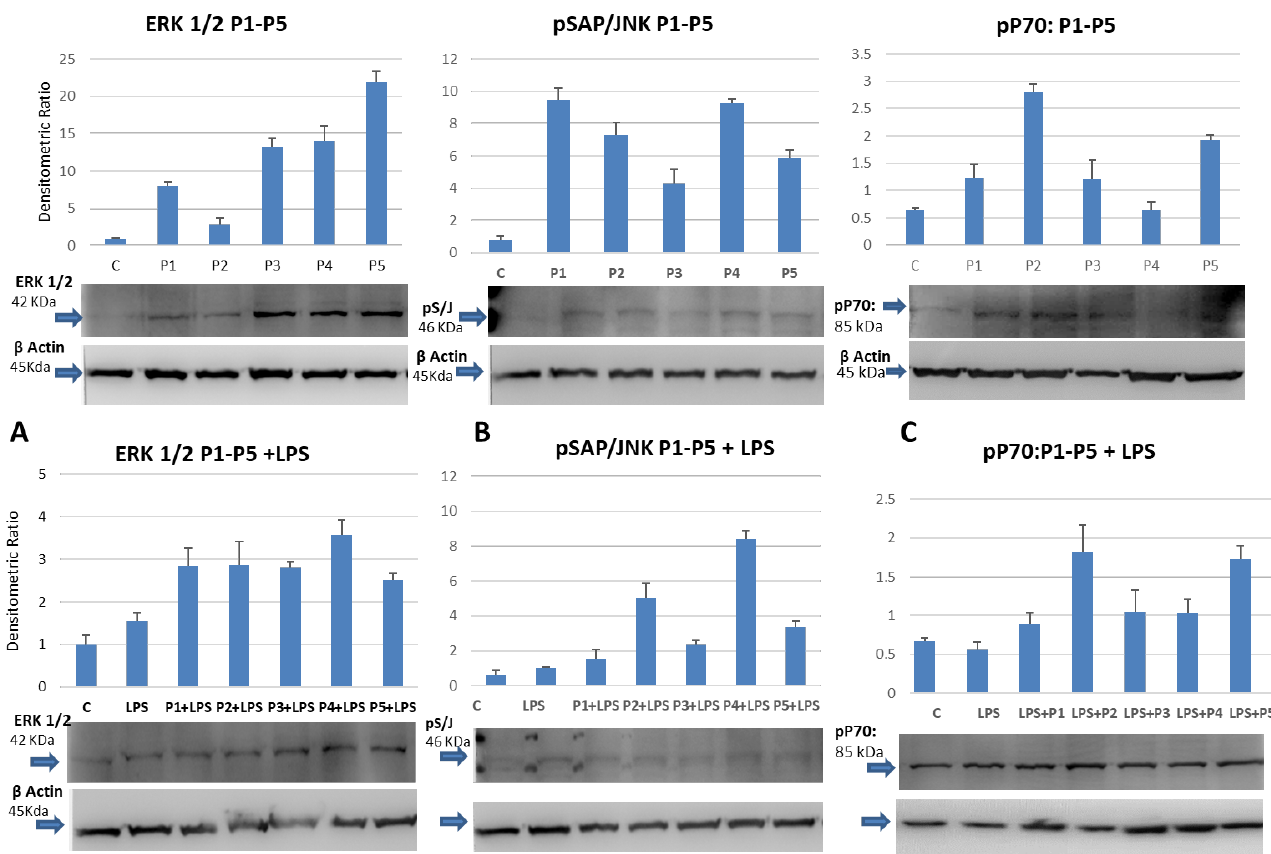
Figure 2. Induction of the mitogen-activated phosho-Erk1/2(4.( A )), SAP/JNK(4.( B )) and p70(4.( C )) (in established monocytes). P1, P2, P3, P4, P5 represent Epitalon, Vilon, Thymogen, Thymalin and Chonluten, respectively as indicated. Bar graphs show the mean values of three independent experiments.